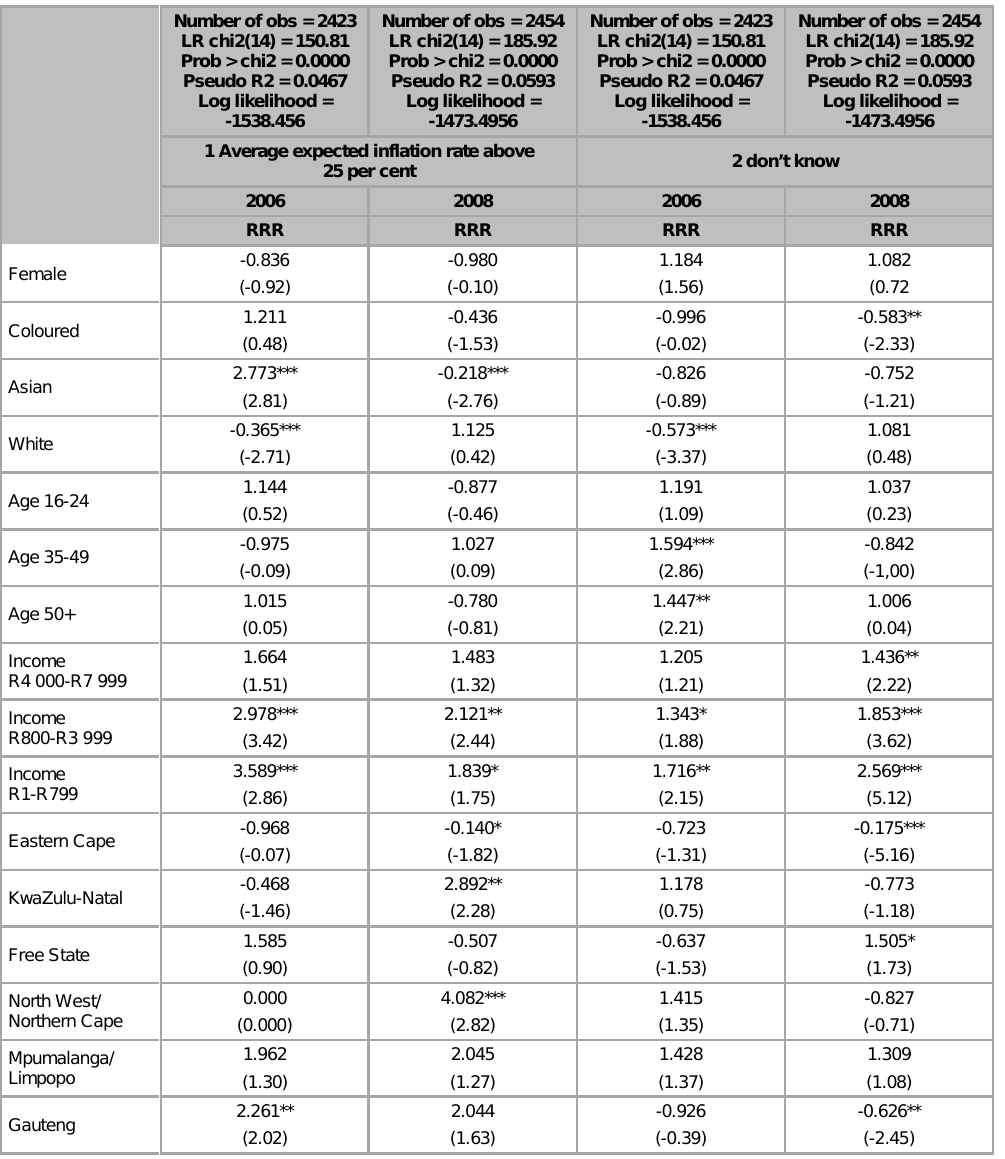
Output from the multinomial regression model for inflation expectations 2006 and